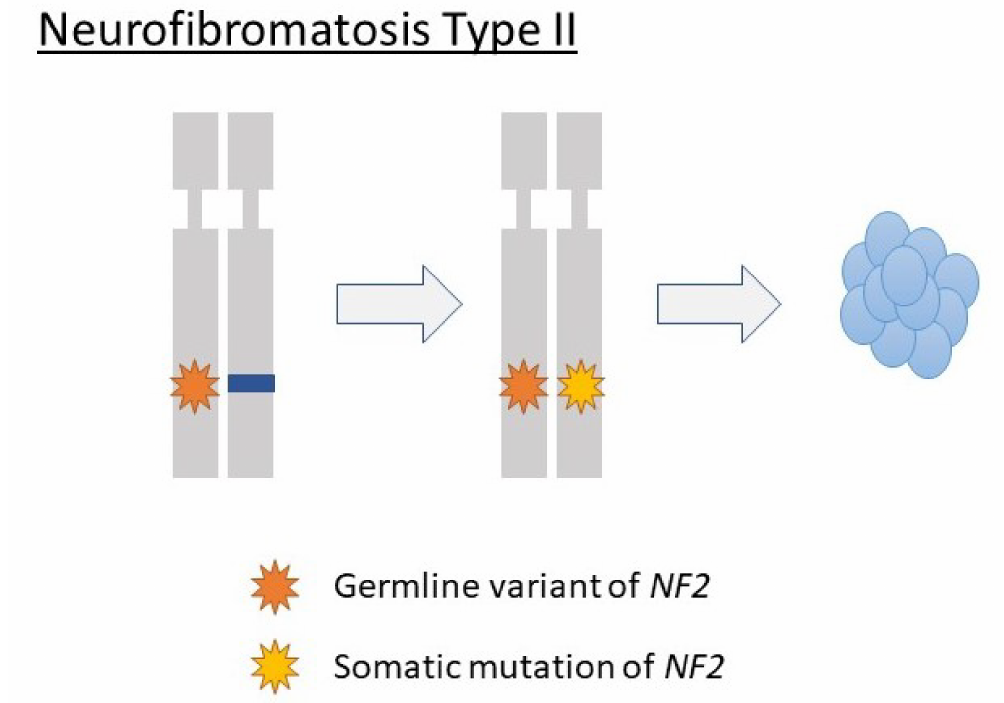
Figure 3. Molecular mechanism of tumorigenesis in vestibular schwannoma caused by neurofibro- matosis type II. In neurofibromatosis type II, both germline variants and somatic mutations of the NF2 gene are associated with the development of vestibular